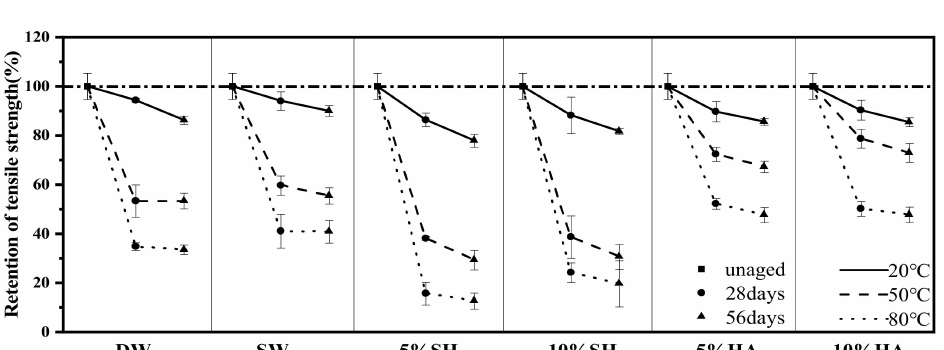
Figure 9. Variation of residual tensile strength as a function of immersion time and temperatures in various